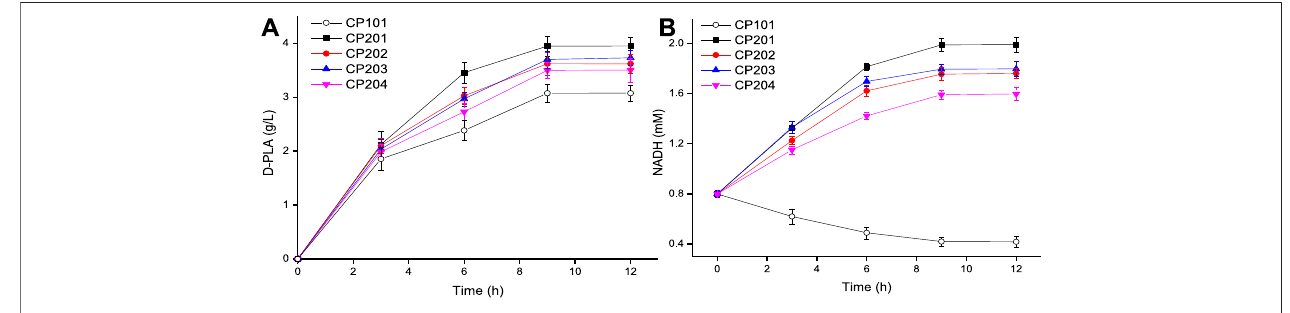
FIGURE 3 | (A) Time course of the production of D-PLA by D-LDH and GlyDH co-expressed strains CP201, CP202, CP203, and CP204; (B) Time course of intracellular NADH concentration. Data are means ± SD ( n (cid:1) 3).